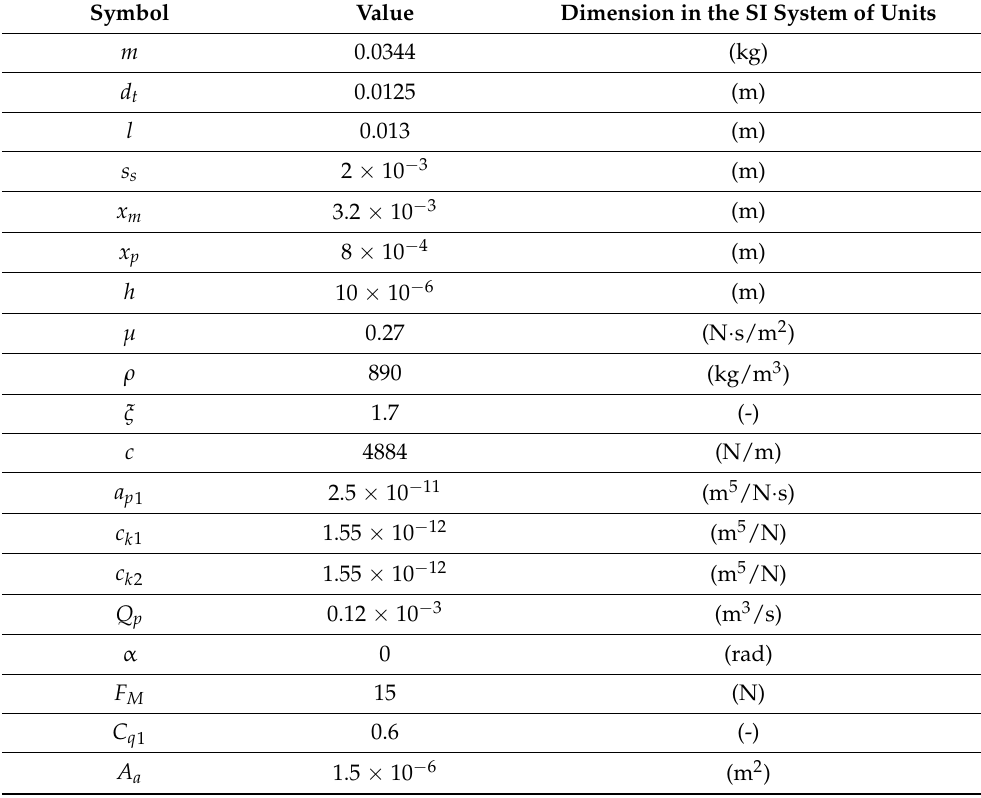
Table 3. The values of the coefficients for the equations system of proposed mathematic model.